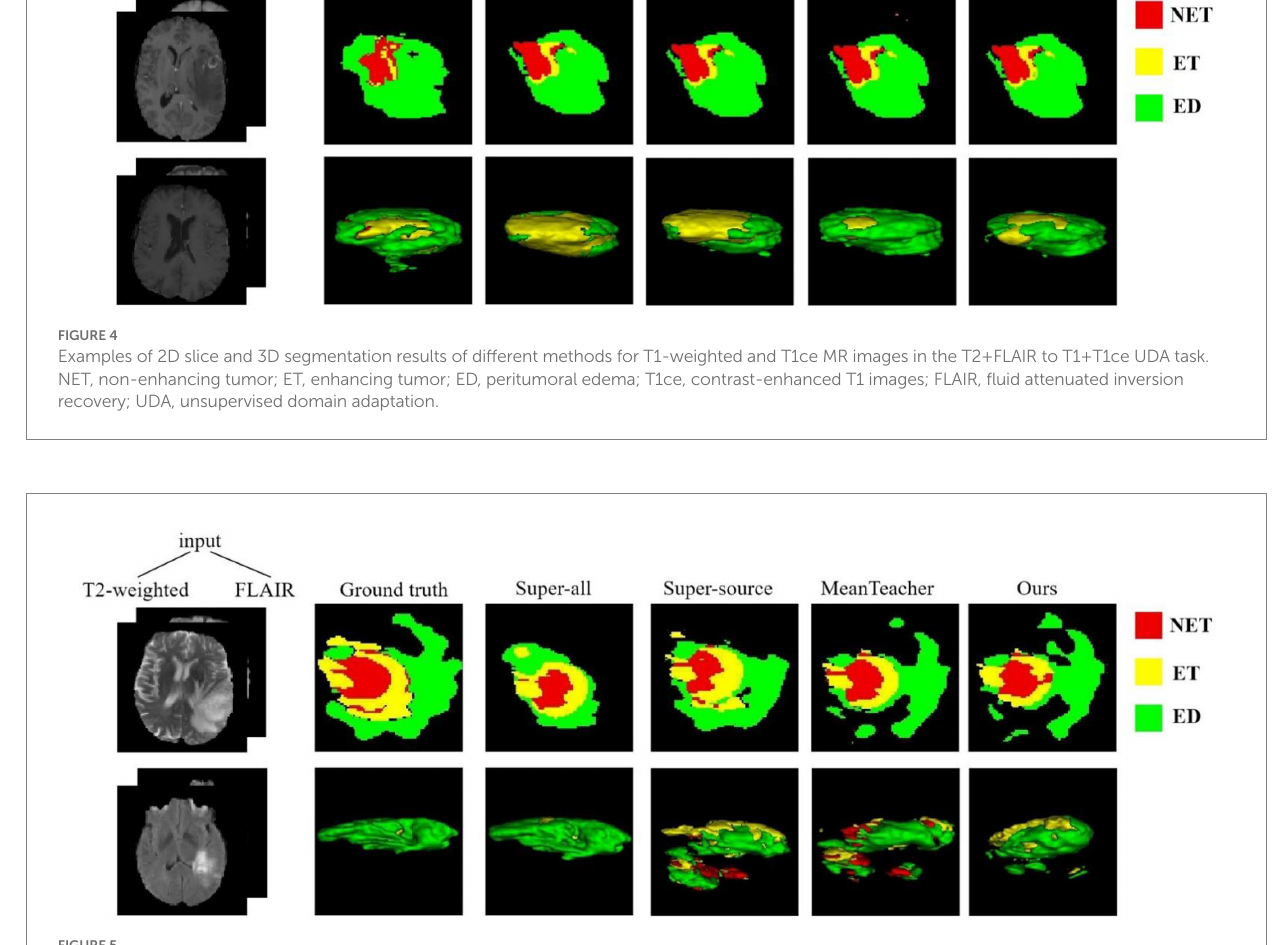
FIGURE 5 Examples of 2D slice and 3D segmentation results of different methods for T2-weighted and FLAIR MR images in the T1 + T1ce to T2 + FLAIR UDA task. T1ce, contrast-enhanced T1-weighted images; FLAIR, fluid attenuated inversion recovery; UDA, unsupervised domain adaptation; NET, non-enhancing tumor; ET, enhancing tumor; ED, peritumoral